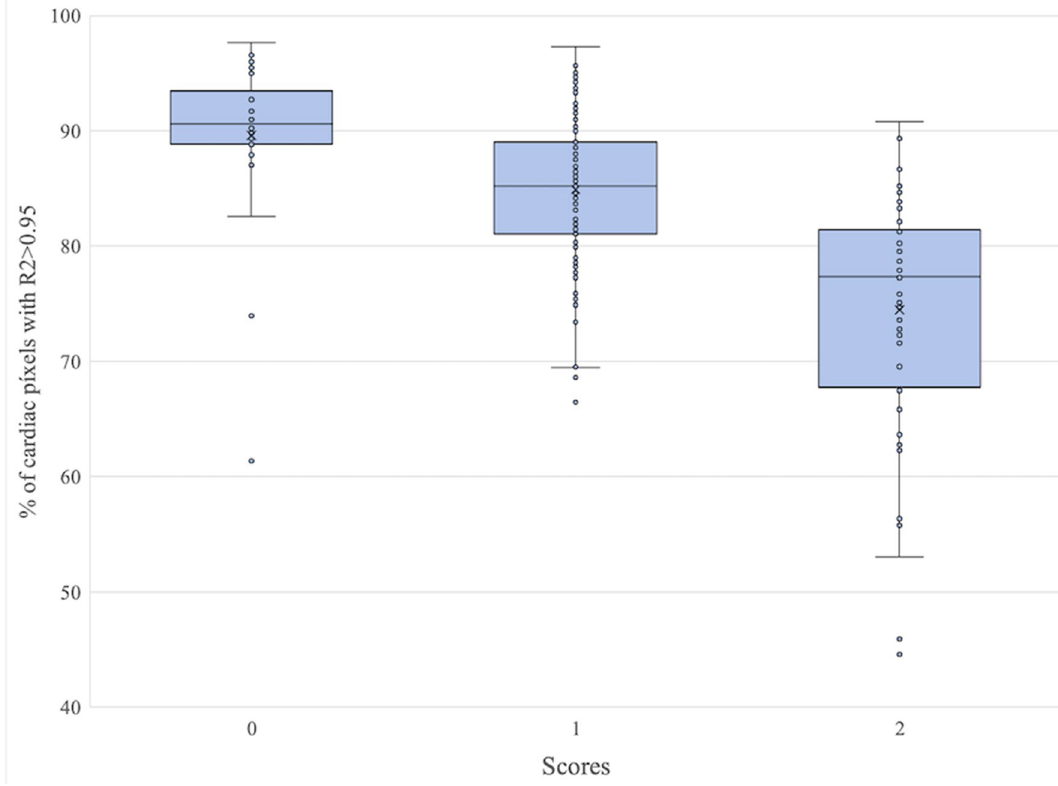
Figure 7. Box and whisker plot of the qualitative evaluation results, showing how the three groups resulting from the visual scoring correlate with the AFP quantitative values. Graph created using Python (Python Software Foundation, Delaware,